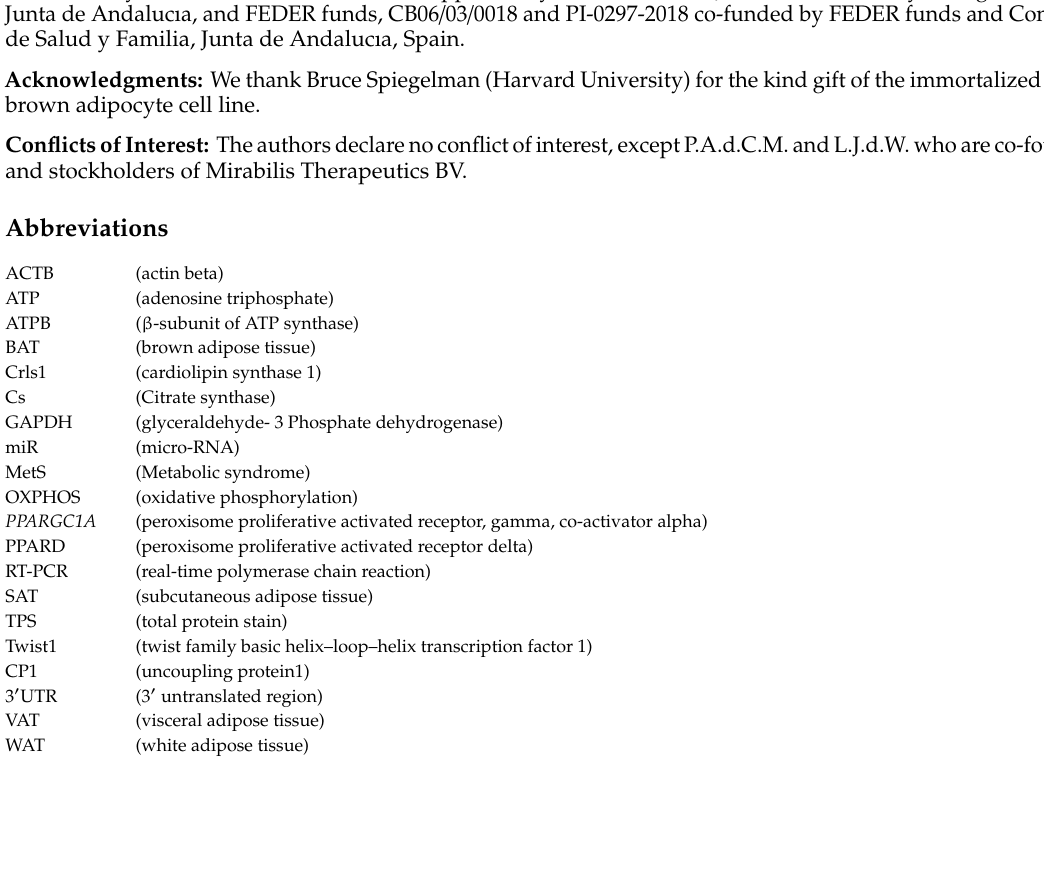
Table S1: Anthropometric and clinical characteristics of healthy and metabolic syndrome subjects: Table S2: Strategy for selecting gene of interest and literature